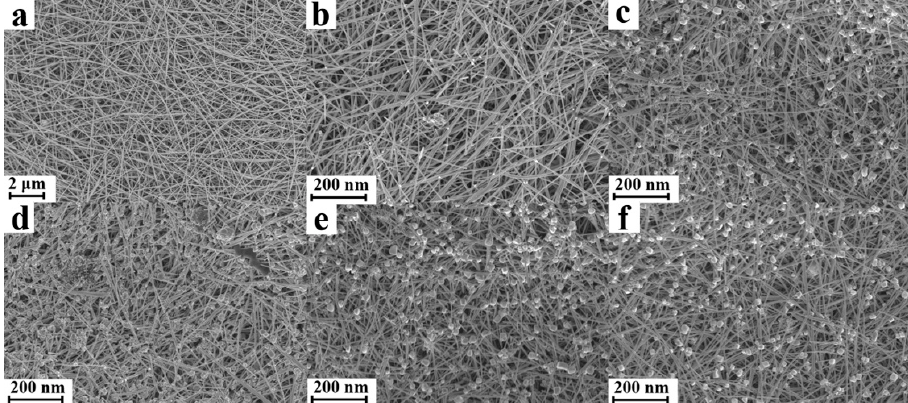
Figure 2. SEM images of silver nanowire membranes according to the CV cycle number: untreated ( a ), 5 cycles ( b ), 10 cycles ( c ), 15 cycles ( d ), 20 cycles ( e ), and 25 cycles ( f ). Further, silver nanowire membranes treated at different temperatures (15 cycles)